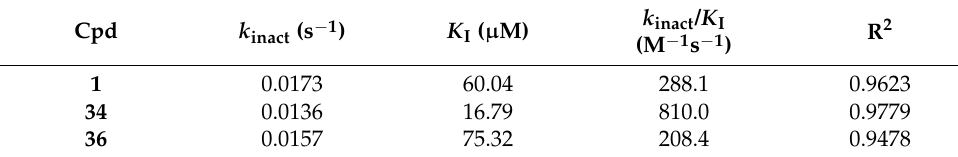
Table 3. Kinetics of covalent inhibition of